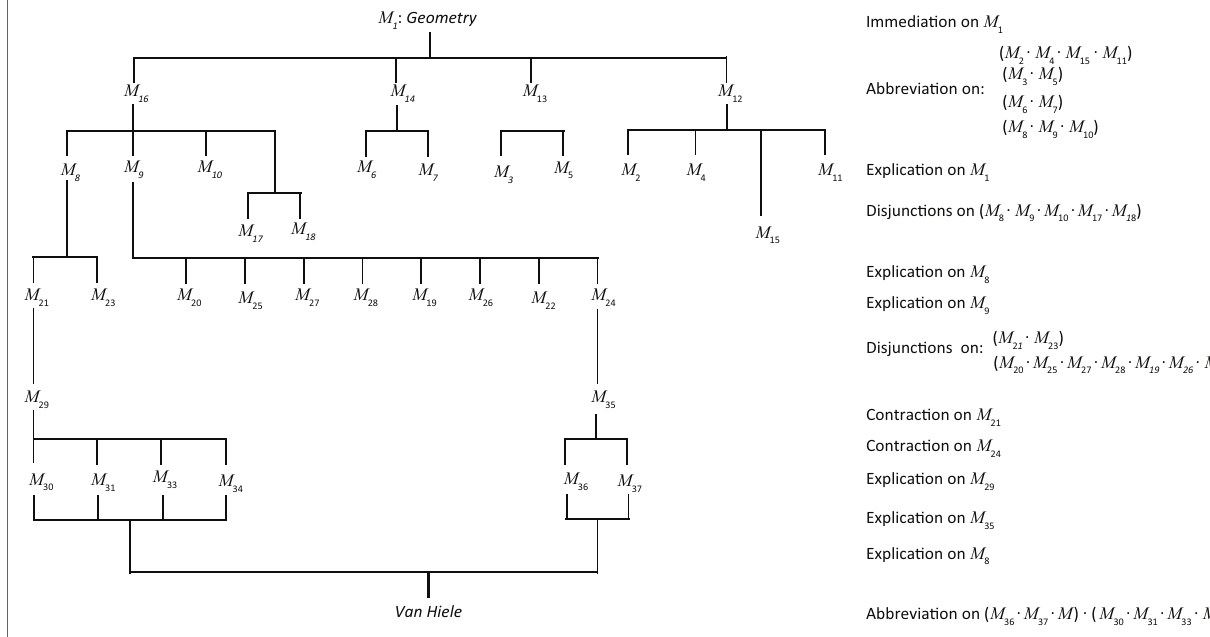
FIGURE 1: Network showing the flow of abbreviations and explications from M